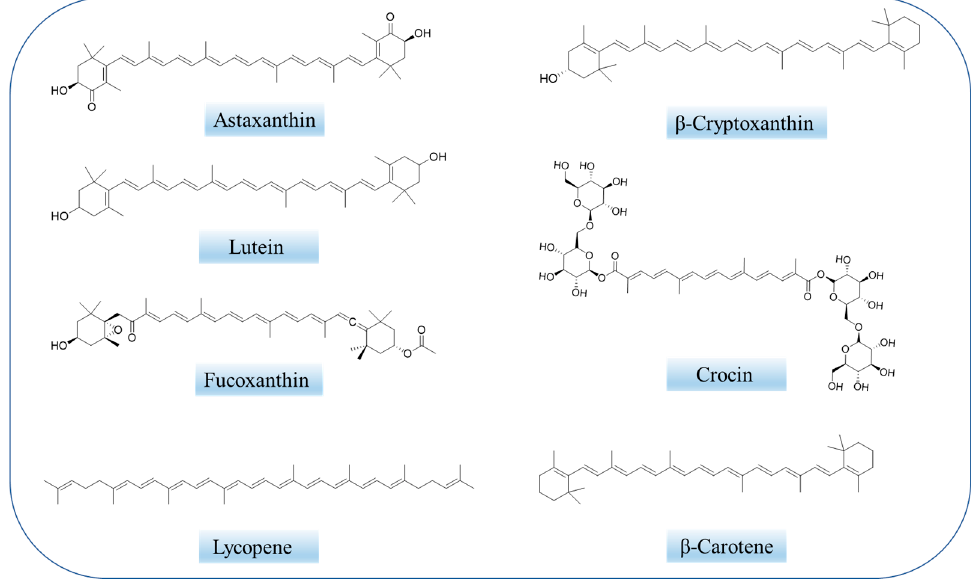
Figure 1. Chemical structures of some carotenoids.